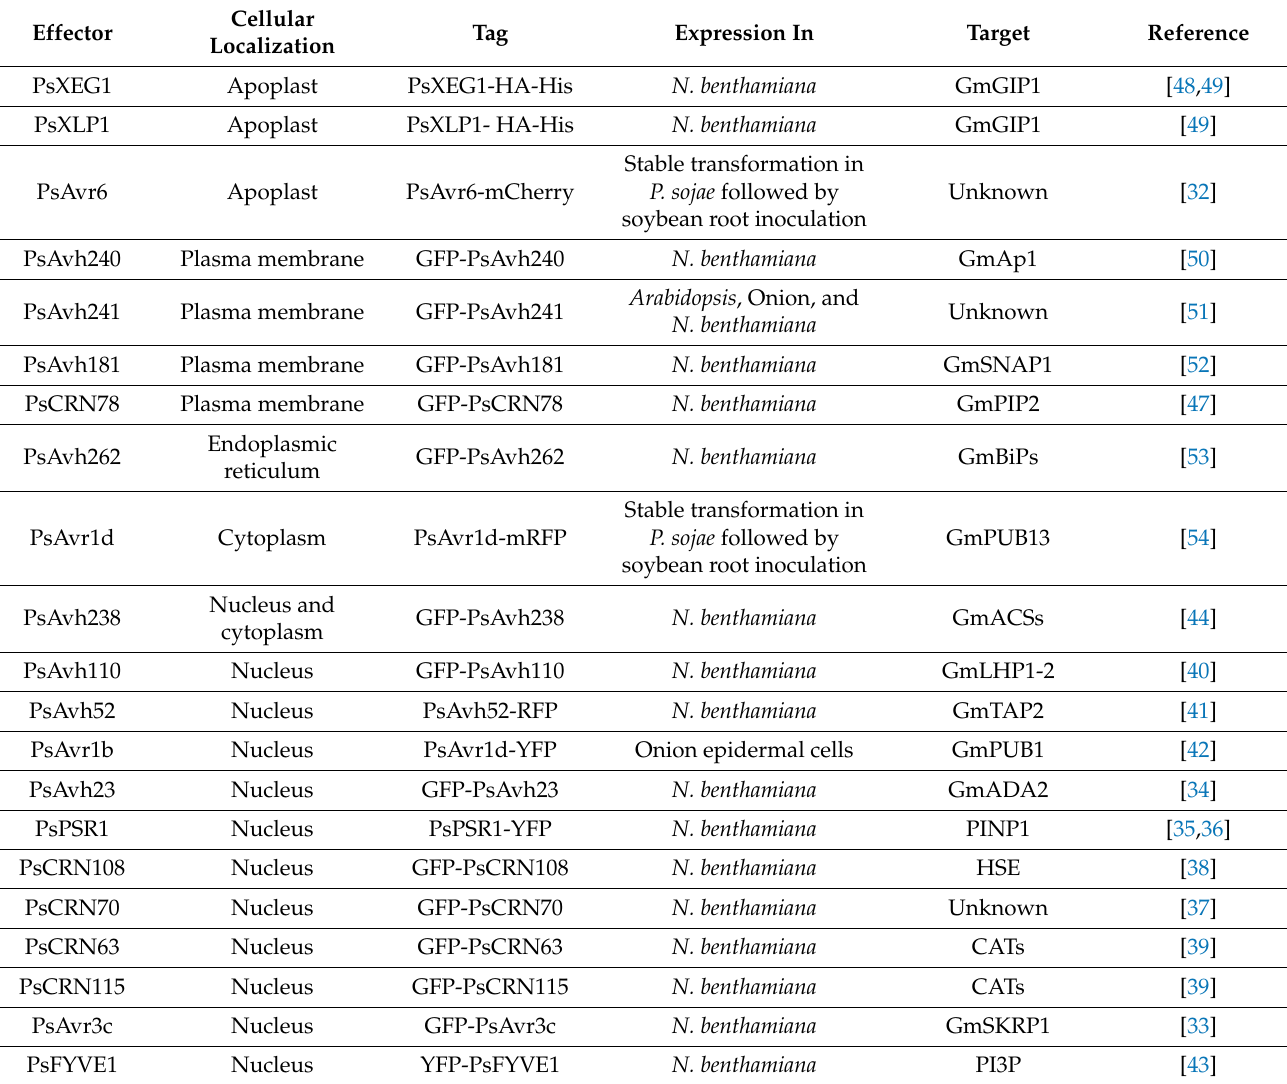
Table 1. Subcellular localization and target proteins of Phytophthora sojae effectors assayed in heterol- ogous systems or natural